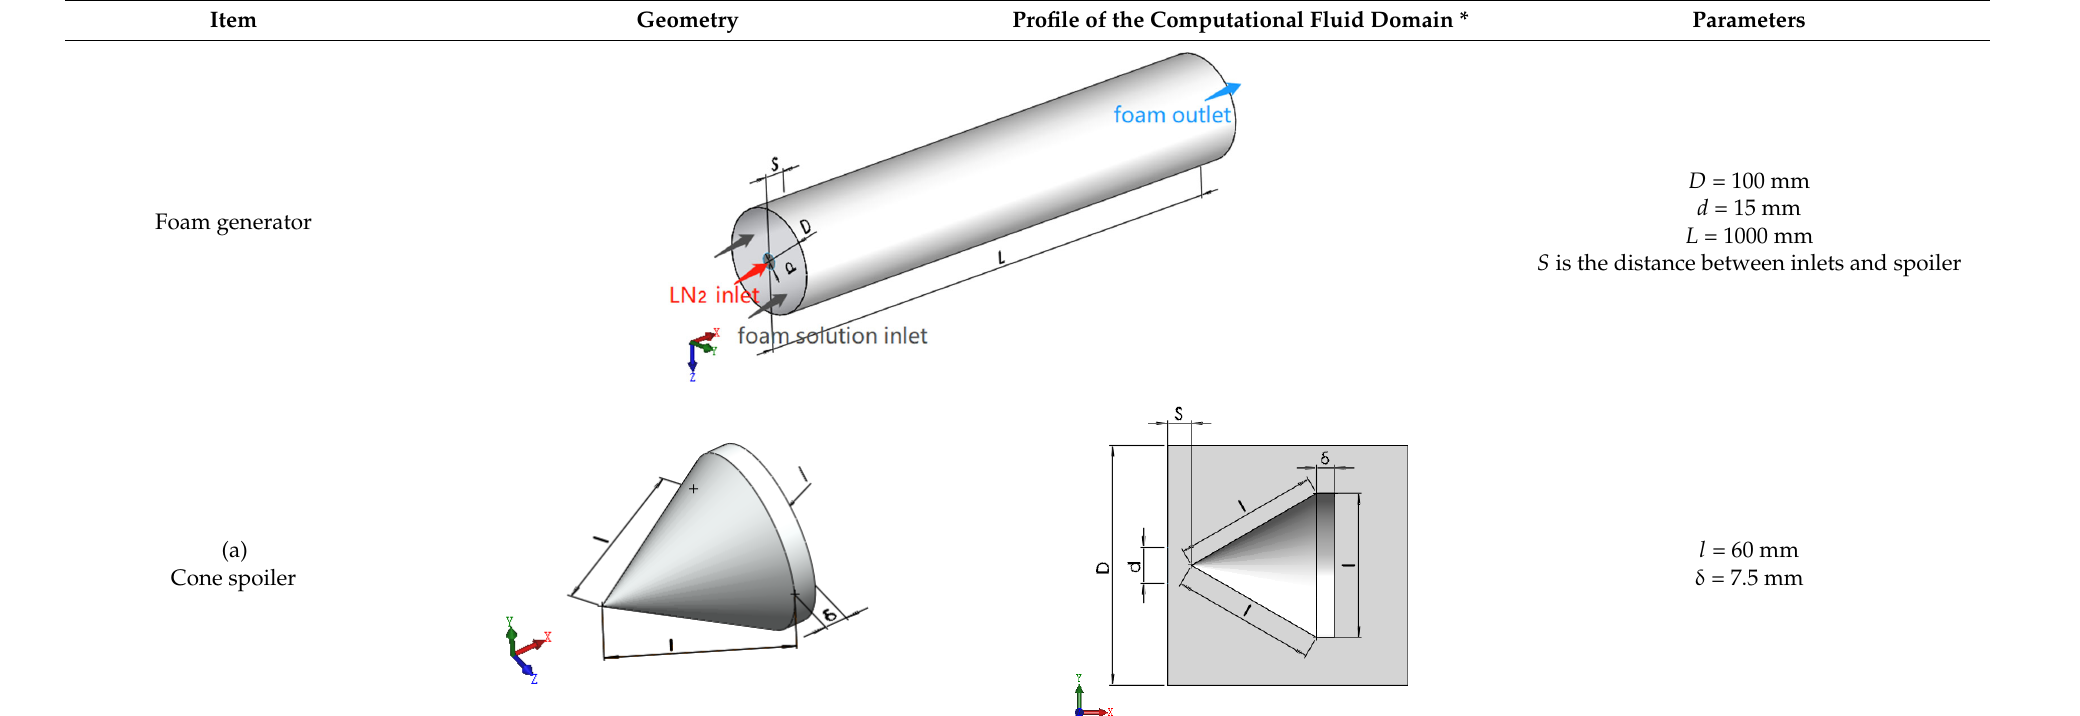
Table 1. The geometric dimensions of the foam generator and spoilers.